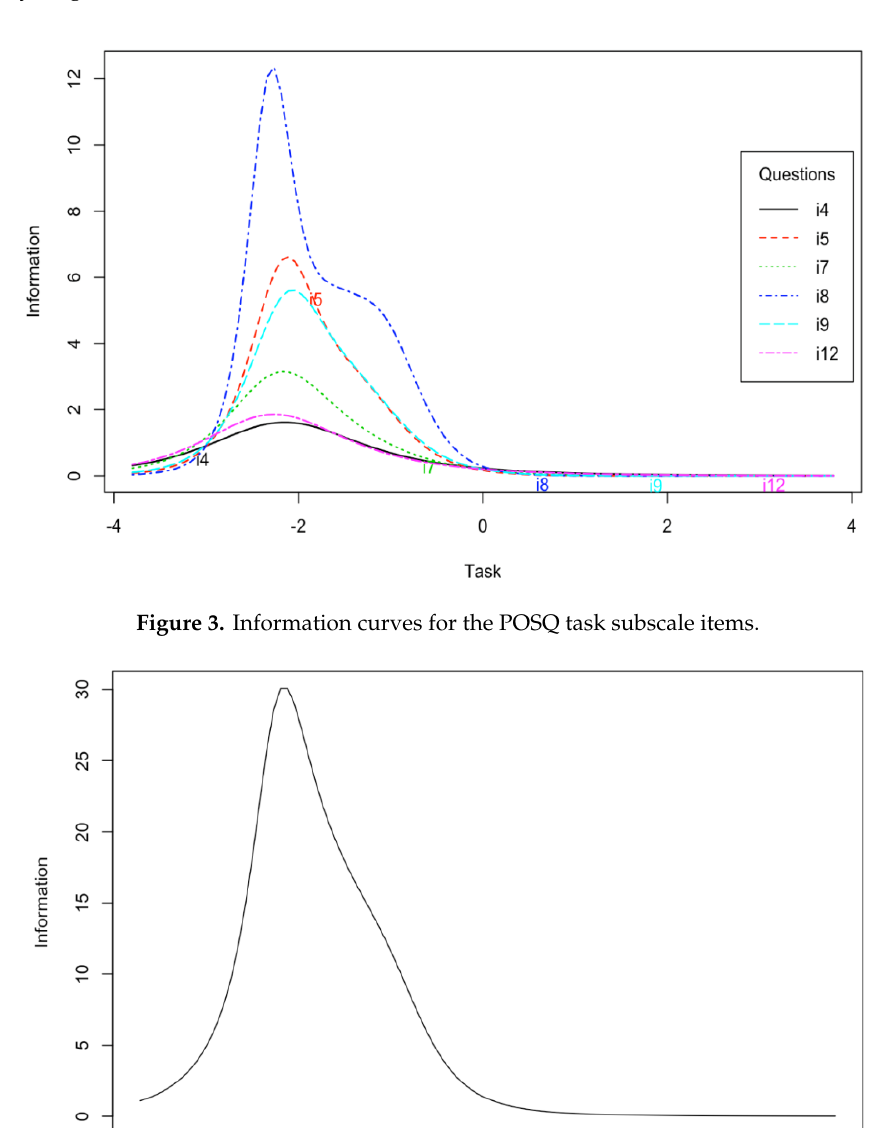
Figure 2. Information curve for the ego subscale.